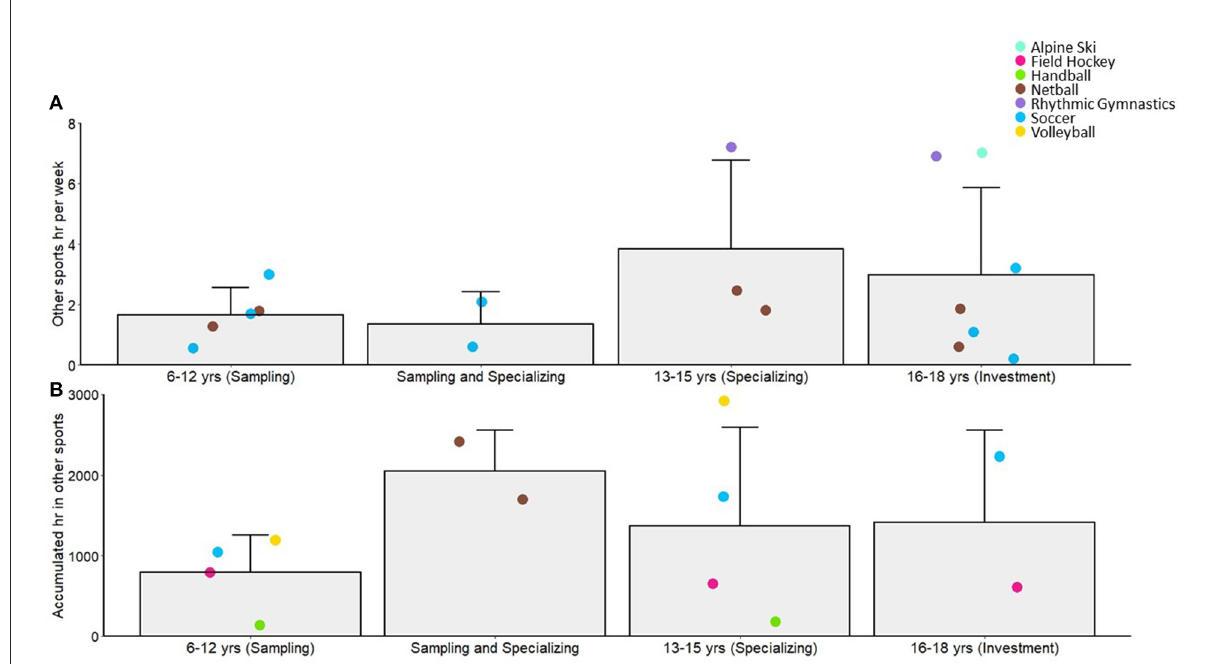
FIGURE5 Sample (bar) and individual study means (colored circles) across different age categories defined in past literature as the sampling, specializing and investment years, for average hours per week in other sports (A) and average accumulated hours in other sports (B) . Error bars show standard deviation and colored circles represent individual groups for each sport/study. The “Sampling and Specializing” category represents data that span the ages in those